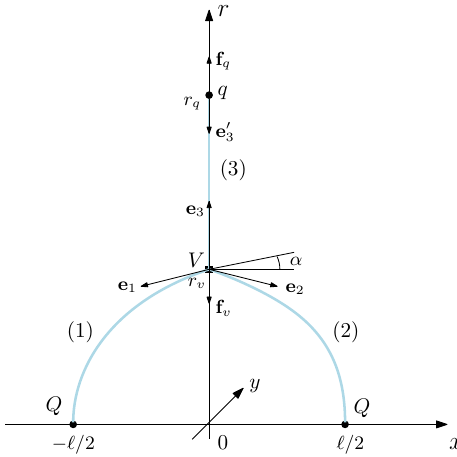
Figure 1 . A static string configuration at small heavy quark separations. The heavy quarks Q are placed on the x -axis, while the light quark q and baryon vertex V on the r -axis, respectively at r = r q and r = r v . The forces exerted on the vertex and light quark are depicted by the arrows. If one works in the static gauge ξ 1 = t and ξ 2 = r , then the boundary conditions for x ( r